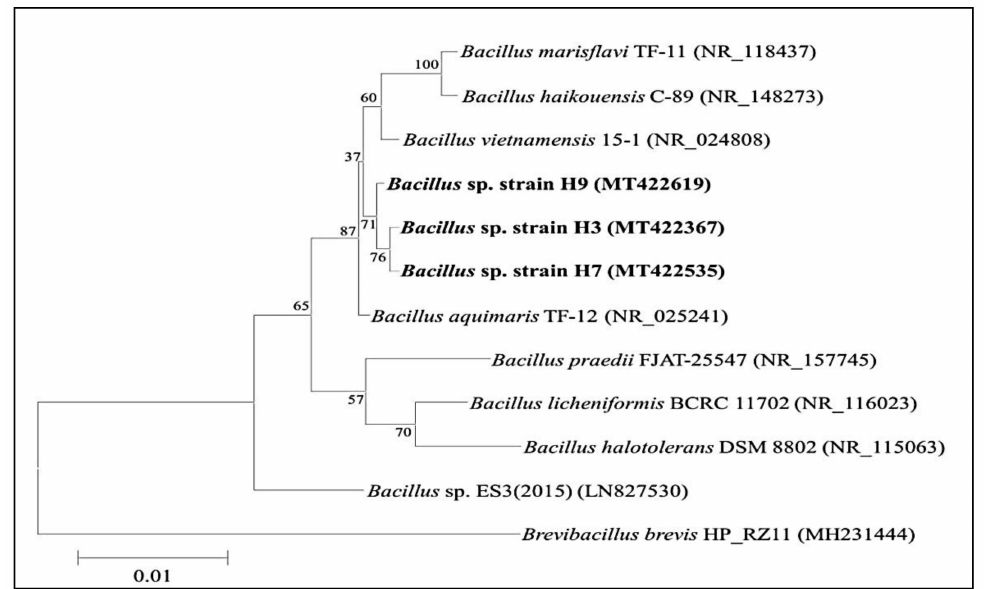
Figure 1. Phylogenetic tree of Bacillus sp. H7 drawn using the neighbor-joining method.